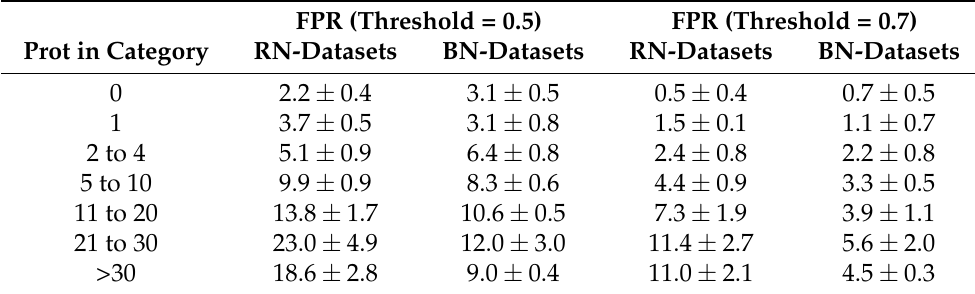
Figure 6. Balancing the BN-datasets. ( a ) Distribution of the proteins according to the number of positive examples or negative examples in which they are involved. ( b ) Distribution of the molecules according to the number of positive examples or negative examples in which they are involved. Table 4. Rate of false positives for proteins with various numbers of known